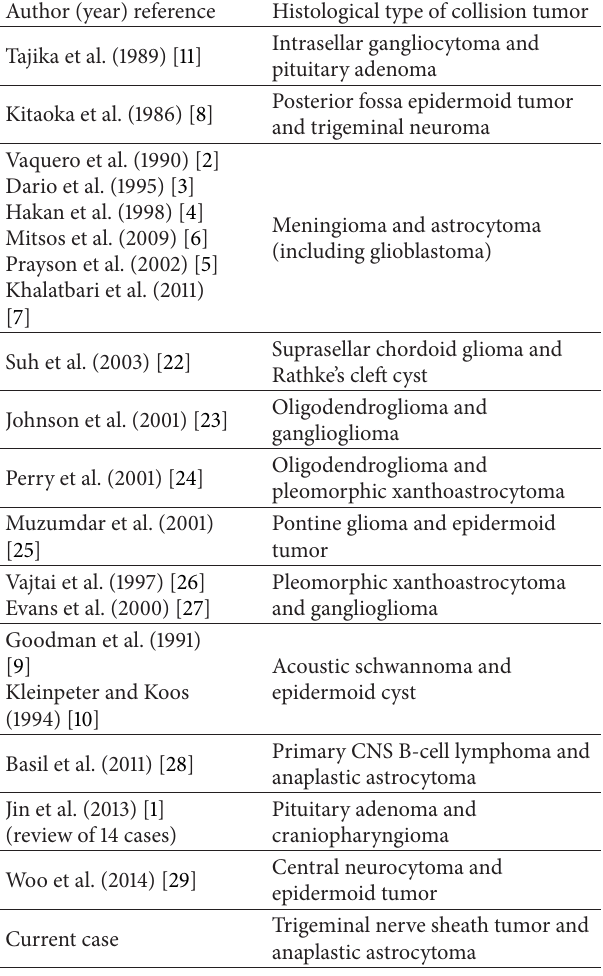
Table 1: Reported primary brain collision tumors in the literature.